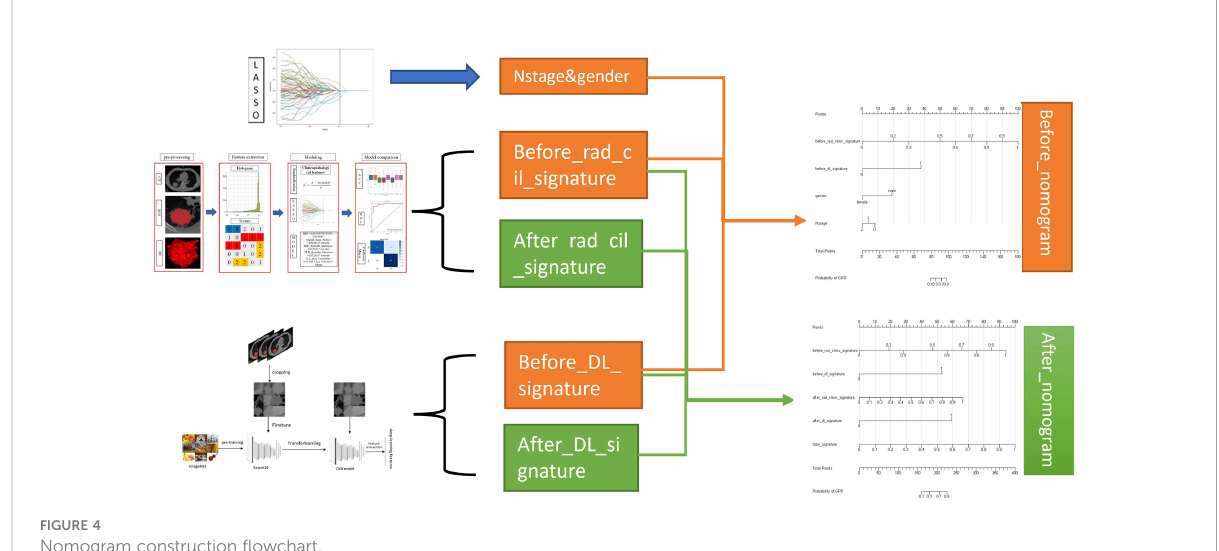
FIGURE 4 Nomogram construction fl